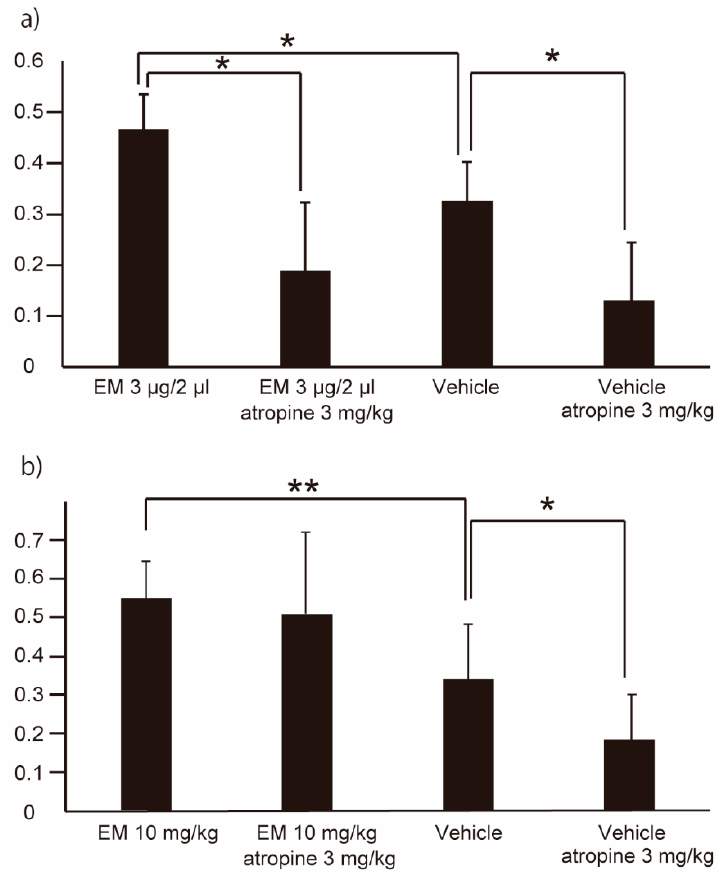
Figure 4. Gastric emptying of human MLNR Tg mice following central (intracerebroventricular) administration of EM only ( n = 3), EM + atropine ( n = 4), vehicle only ( n = 6), or vehicle + atropine ( n = 4) ( a ), or following peripheral (intraperitoneal) administration of EM only ( n = 10) EM + atropine ( n = 7), vehicle only ( n = 14), or vehicle + atropine ( n = 7) ( b ). Values represent the mean ± SD for the indicated number of animals. * p < 0.05, ** p < 0.01 (One-way ANOVA with Tukey post-hoc test).